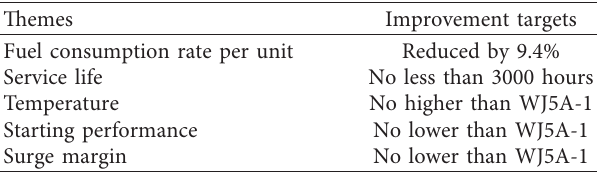
Table 1: The improvement targets of WJ5E.